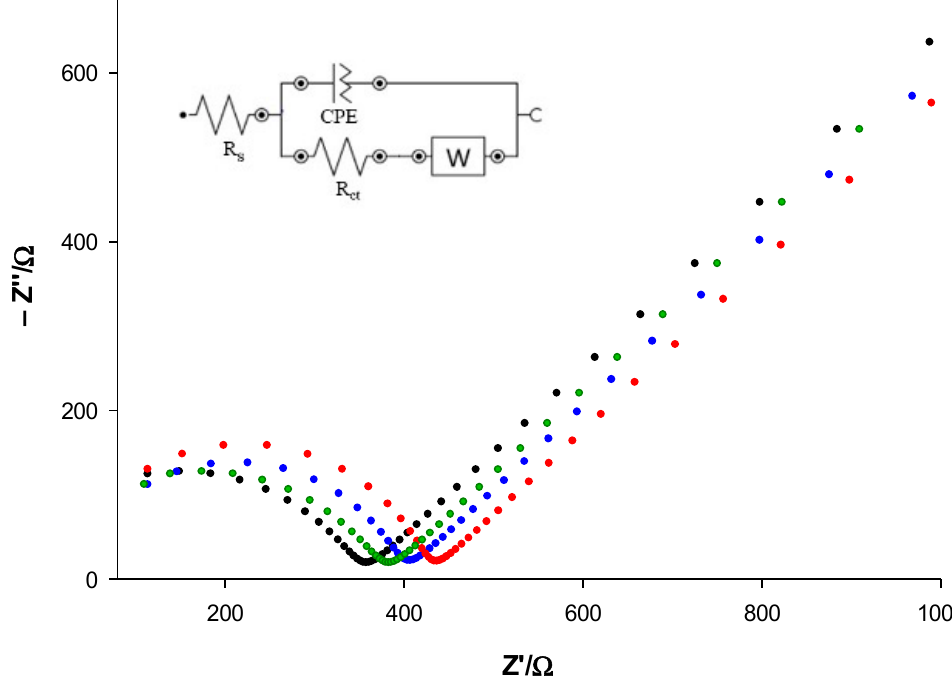
Figure 5. Nyquist plots of GPH/SPE (green), ChitNPs/GPH/SPE (black), Tyr/ChitNPs/GPH/SPE (blue), and Tyr/EDC-NHS/ChitNPs/GPH/SPE (red) measured in the presence of 5 mM [Fe(CN) 6 ] 3 − /4 − containing 0.1 M KCl solution. The inset shows the equivalent circuit used for fitting the experimental data.